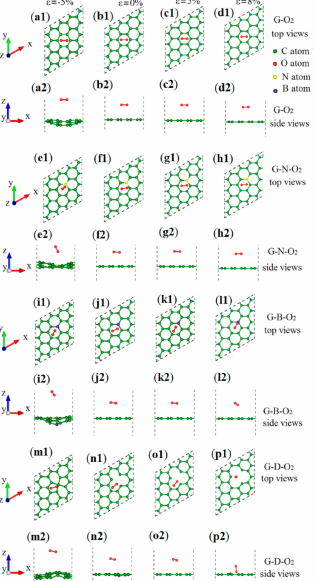
Figure 1. ( a1 – d2 ) Top and side views of G–O 2 ; ( e1 – h2 ) G–N–O 2 ; ( i1 – l2 ) G–B–O 2 ; and ( m1 – p2 ) G–D–O 2 under equibiaxial strains of − 5%, 0%, 5%, and 8%. The green, red, yellow and blue balls refer to the C, O, N, and B atoms, respectively, and the insides of dashed lines denote the unit cells of the